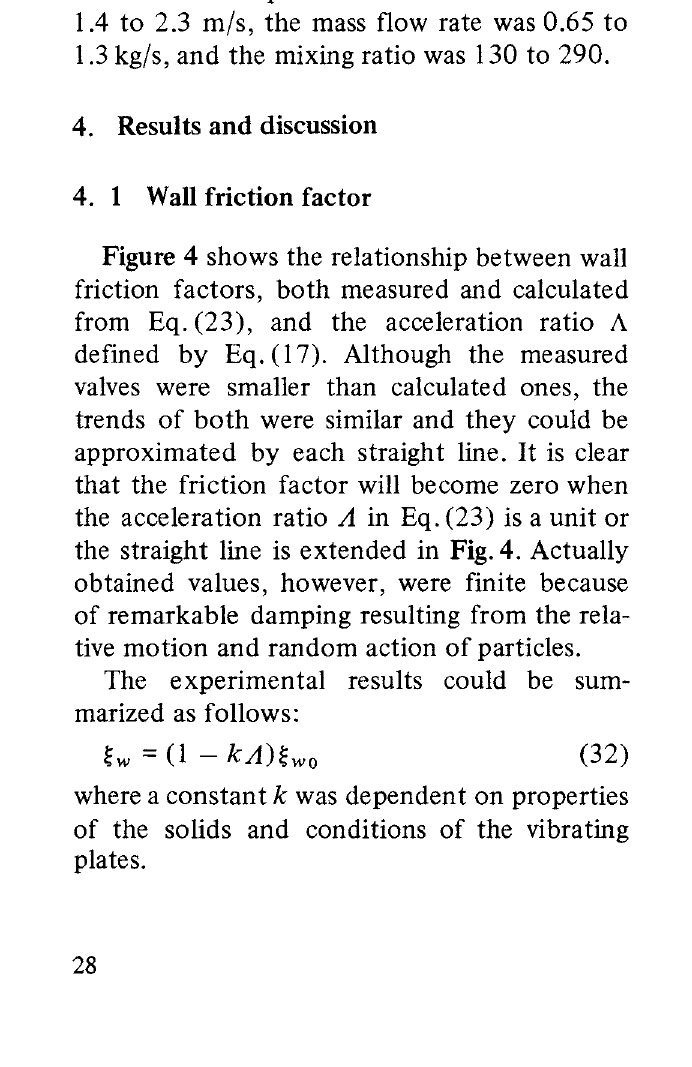
Fig. 4 Relationship between ratio of acceleration A and surface friction factor